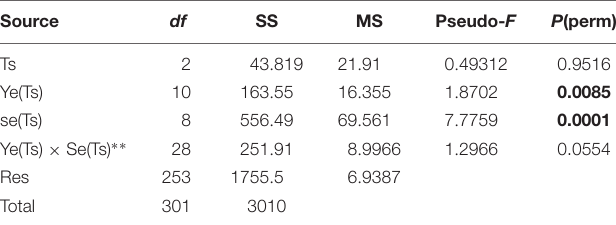
TABLE 3 | Results of PERMANOVA analyses for the meteorological and hydrographic conditions, considering the factors Trophic status phase (Ts), Year (Ye), and Season